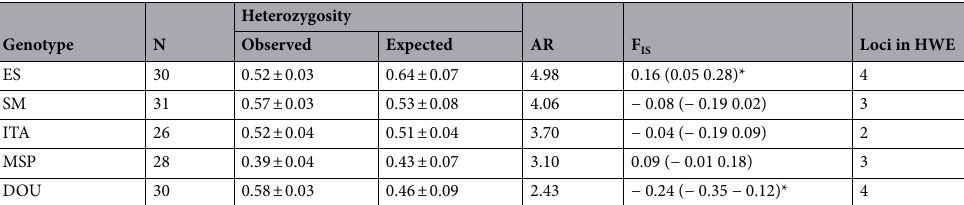
Table 4. Genetic diversity parameters of native populations of S. terebinthifolia from five ecoregions in the Atlantic Forest biome using microsatellites markers. Values between parenthesis correspond to 95% confidence interval calculated using 1000 bootstrap resamples. N, number of individuals; AR, allelic richness; F IS , coefficient of inbreeding; HWE, number of loci showing deviations from Hardy–Weinberg Equilibrium; ES, São Mateus ES; SM, Santa Maria RS; ITA, Itaparica BA; MSP, Morro de São Paulo BA; DOU, Dourados MS.